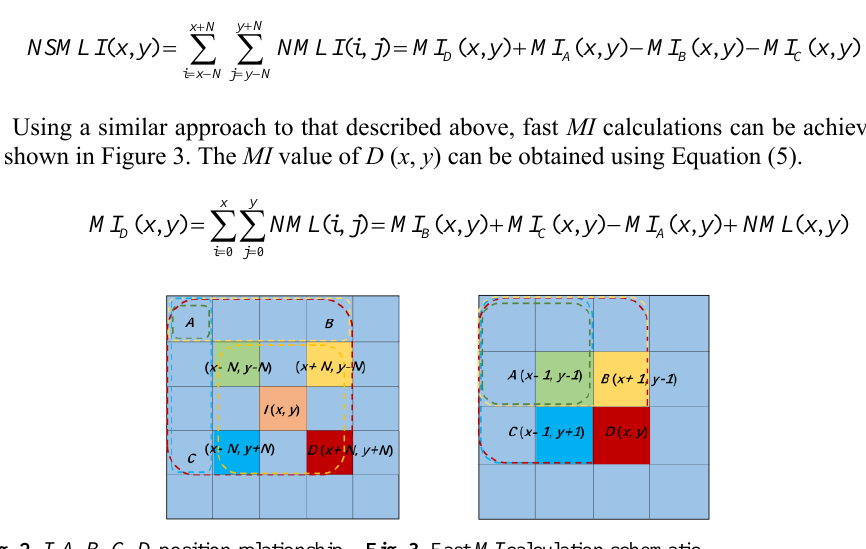
Fig. 2. I , A , B , C , D position relationship. Fig. 3. Fast MI calculation